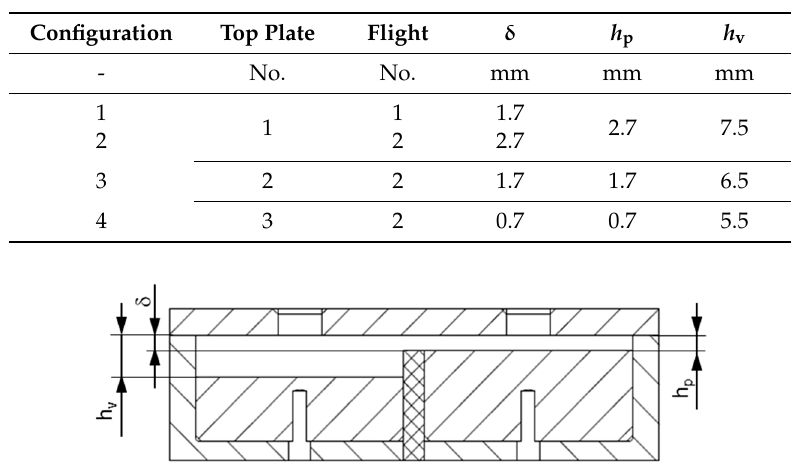
Figure 6. Cross-sectional view of the flow channels.